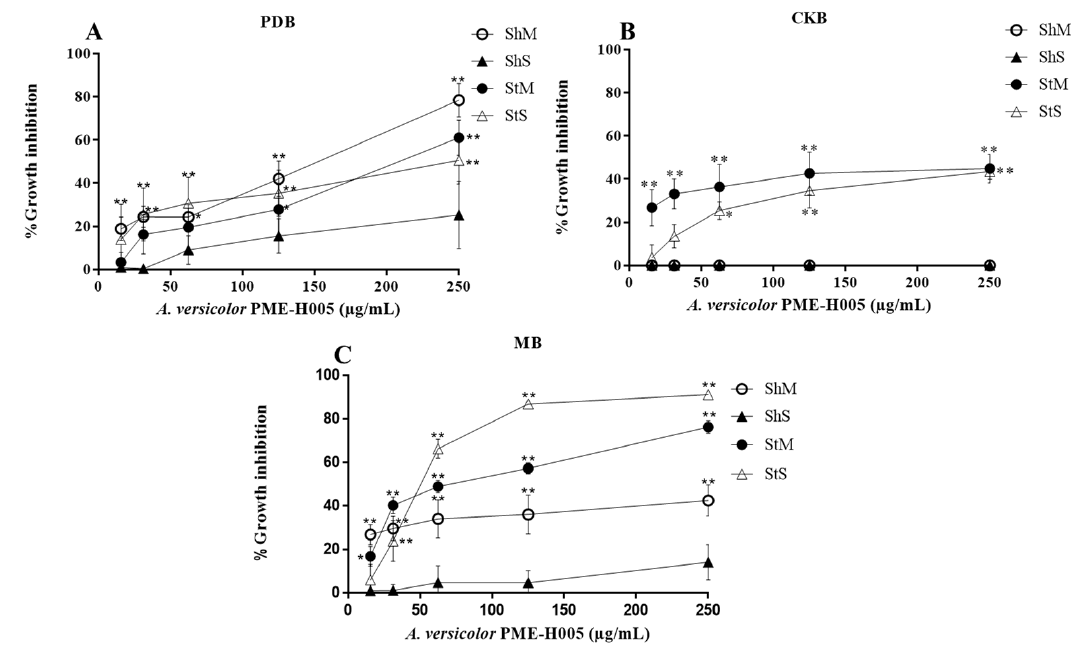
Figure 3. Percentage growth inhibition of A. versicolor PME-H005 strain methanol extracts against L5178Y-R cells in different media and culture conditions. ( A ) PDB, ( B ) CKB, and ( C ) MB. Data represent the mean ± SD of three replicate determinations from three independent experiments. * p < 0.05, ** p < 0.01, as compared with the untreated control, using the Kruskal–Wallis test. Sh, shaking; St, static; M, mycelium; S, spore.